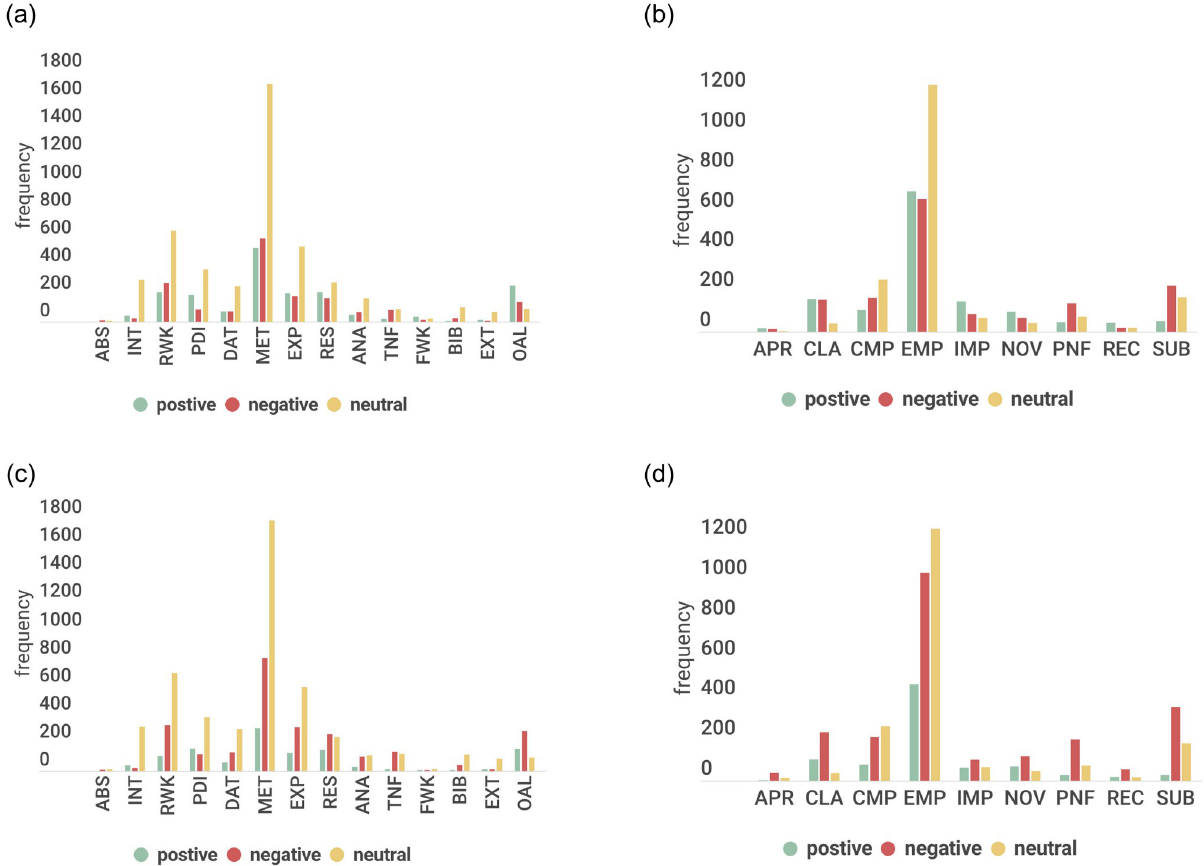
Fig 5. Sentiment distribution for labels across Layer 1 and Layer 2 for ACC and REJ papers. (a) Sentiment for Layer1-ACC. (b) Sentiment for Layer2-ACC. (c) Sentiment for Layer1-REJ. (d) Sentiment for Layer2-REJ.